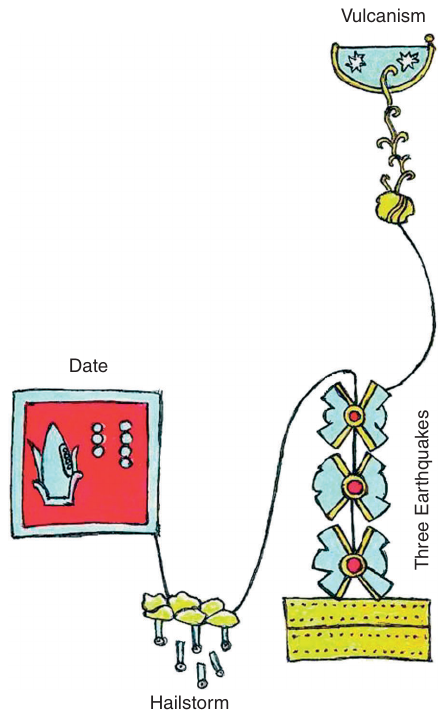
Hailstorm Fig. 3. Pictograms coming from Pre-Columbian or Early Post-Conquest Codices.